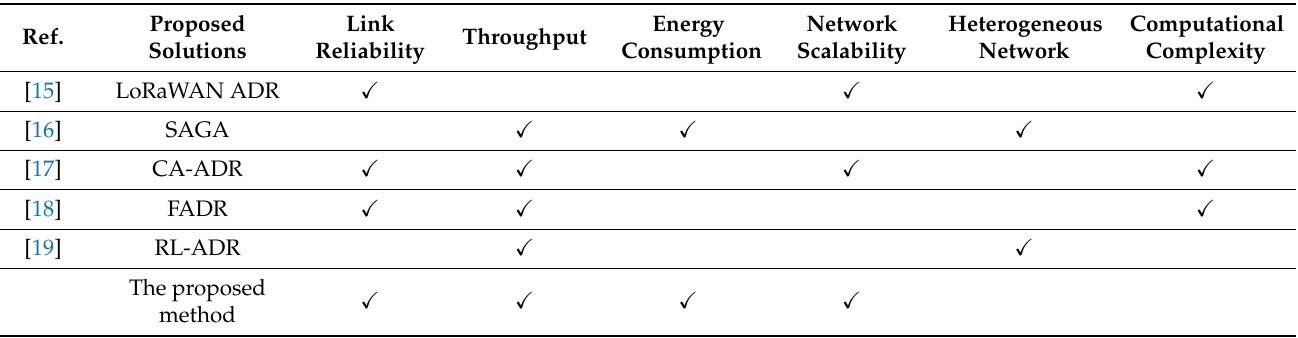
Table 1. Comparison of Adaptive Data Rate